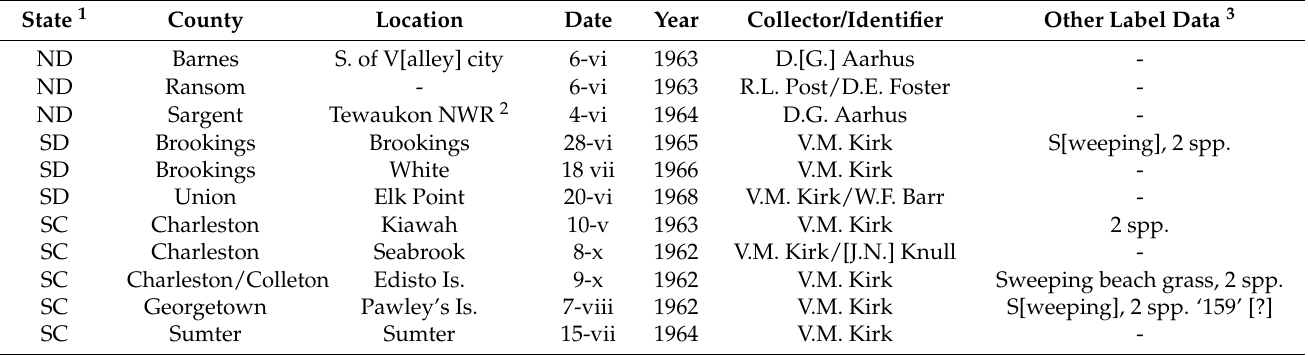
Table 3. List of I. tabida specimens (pinned adults) in the NDSIRC (North Dakota State Insect Reference Collection, NDSU, Fargo, ND,